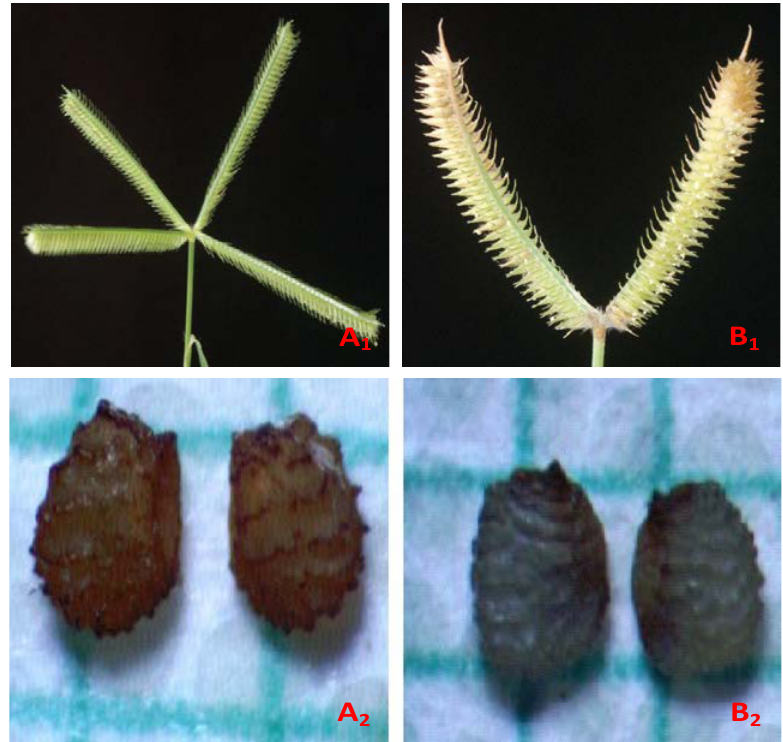
Fig. 2. The inflorescence and the caryopsis of Dactyloctenium aegyptium (A 1 and A 2 ) and D. aristatum (B 1 and B 2